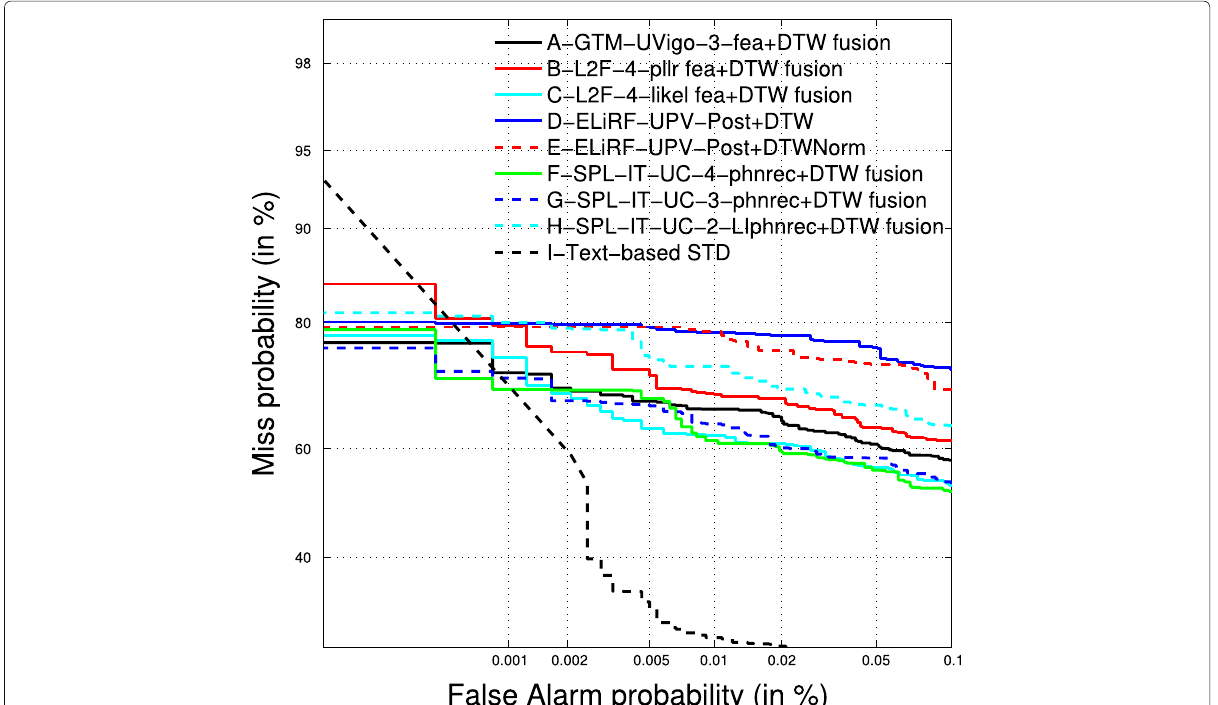
Fig. 6 DET curves of the QbE STD and the text-based STD systems on the development